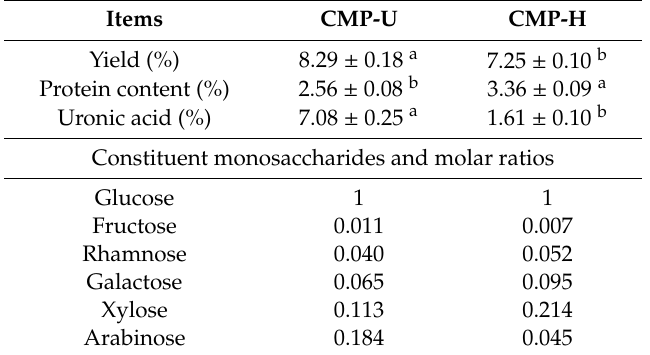
CMP-H: C. morifolium polysaccharides obtained by hot reflux extraction; CMP-U: C. morifolium polysaccharides obtained by ultrasonic assisted extraction; different letters (a, b) in superscript for each index denote a significant difference ( p < 0.05).